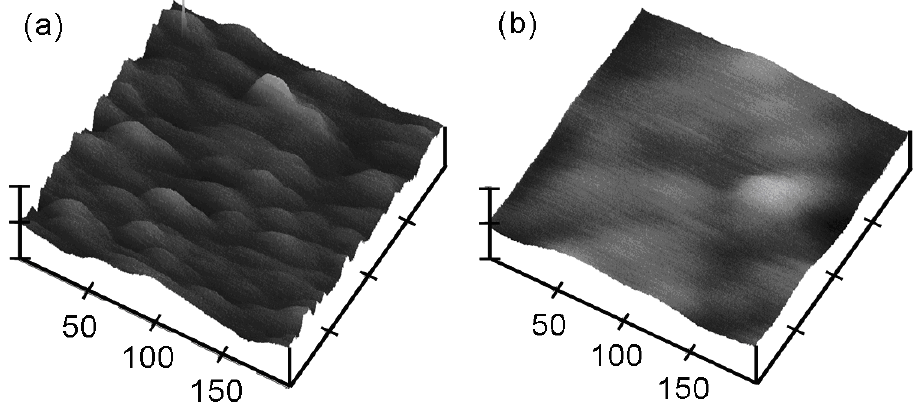
Figure 12. AFM micrographs of the surface of La ( b ) x = 0.09